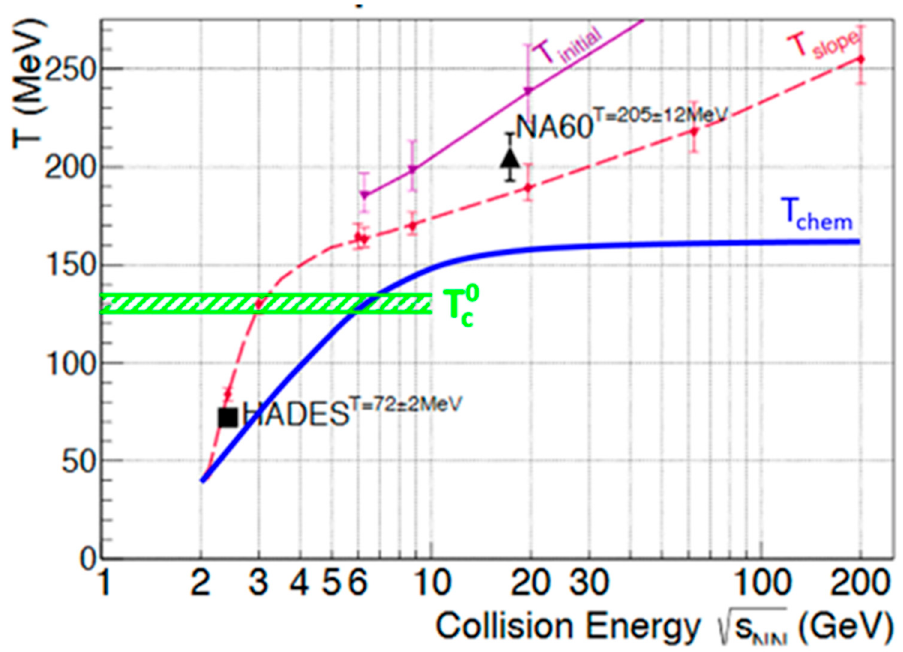
Figure 1. Fireball temperatures as function of collision energy [4]. The purple line and the magenta dashed line are calculated by a coarse-graining method applied to a transport model [5], with T initial being the initial temperature and T slope being derived from the dilepton invariant mass distribution in the range above 1 GeV/c 2 . The NA60 [2] and HADES [3] data points are extracted from measured dilepton invariant mass spectra (see text). The blue solid line represents the chemical freeze-out curve [6], while the green dashed area is the upper bound for the temperature of the critical endpoint calculated by lattice QCD [7].